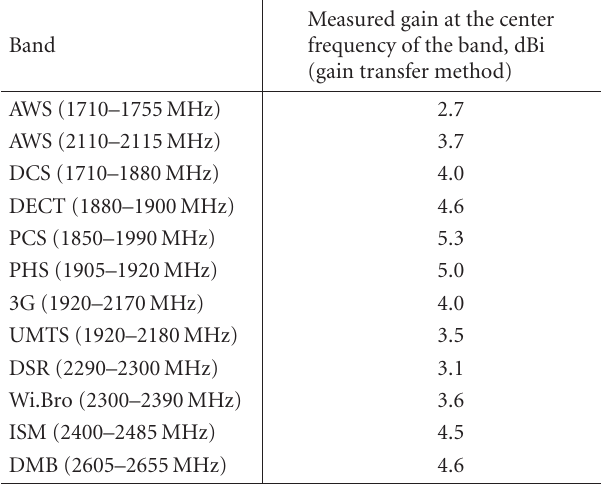
Table 1: Measured gain of the proposed antenna in di ff erent bands [ L = 67, W G = 67, L G = 29, L M = 15, W M = 3, W R = 7 . 5, L R = 19, R